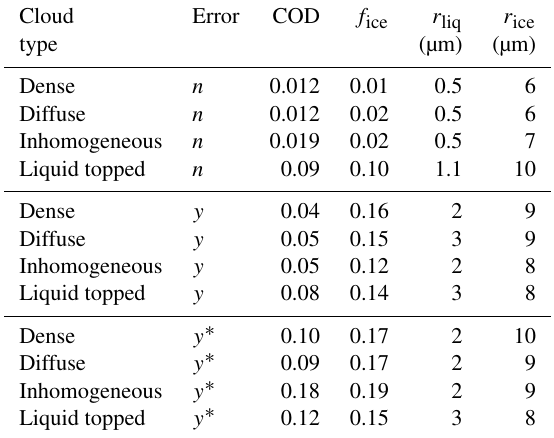
Table 5. Root-mean-square errors in retrieved cloud properties for vertically varying clouds: cloud optical depth (COD), ice fraction ( f ice ), and effective radii of liquid and ice ( r liq and r ice ). For the upper set of cases, errors were not imposed on observations (er- ror = n ) and true cloud heights were used. The middle set of cases includes imposed errors with true cloud heights (error = y ), while the lowest set includes imposed errors with retrieved cloud heights (error = y ∗ ; see text).